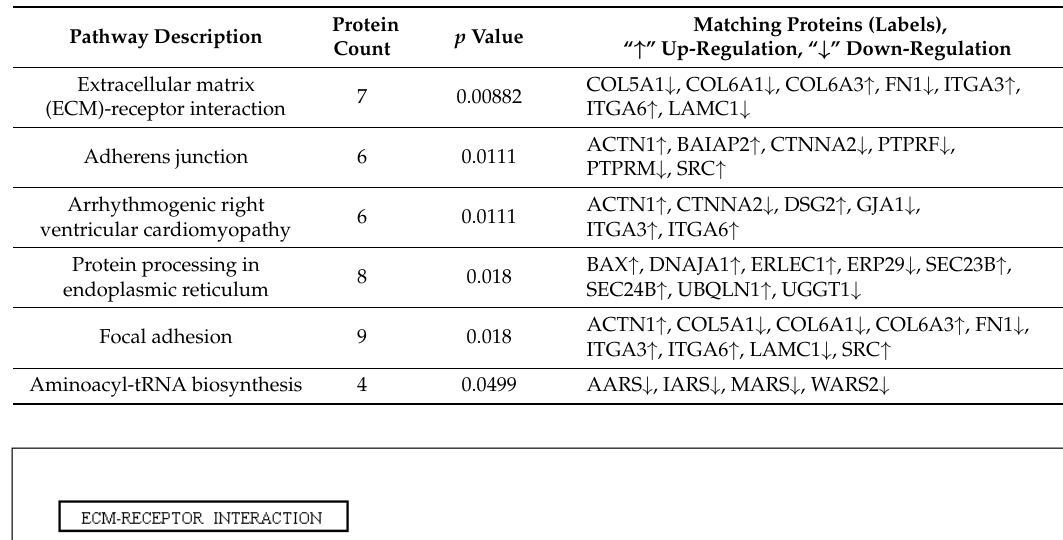
Table 1. Kyoto Encyclopedia of Genes and Genomes (KEGG) pathways enriched in the PPCs vs. FPCs.